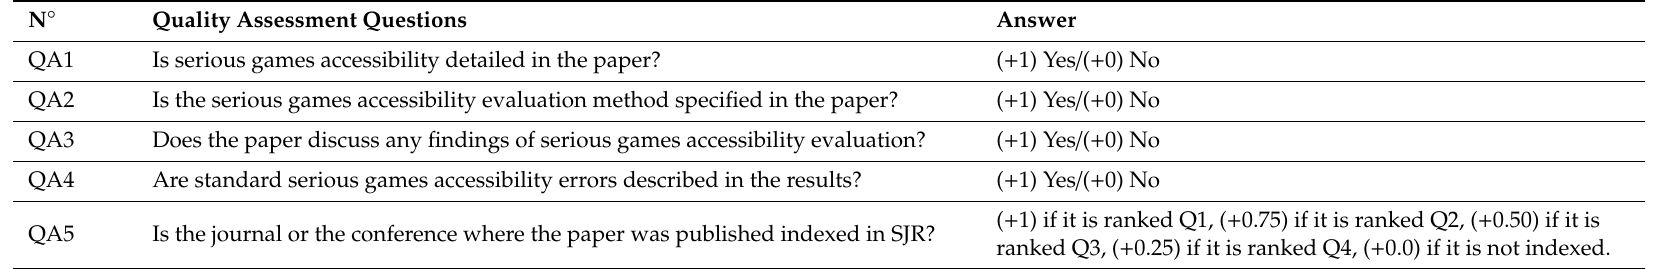
Table 2. Article quality evaluation